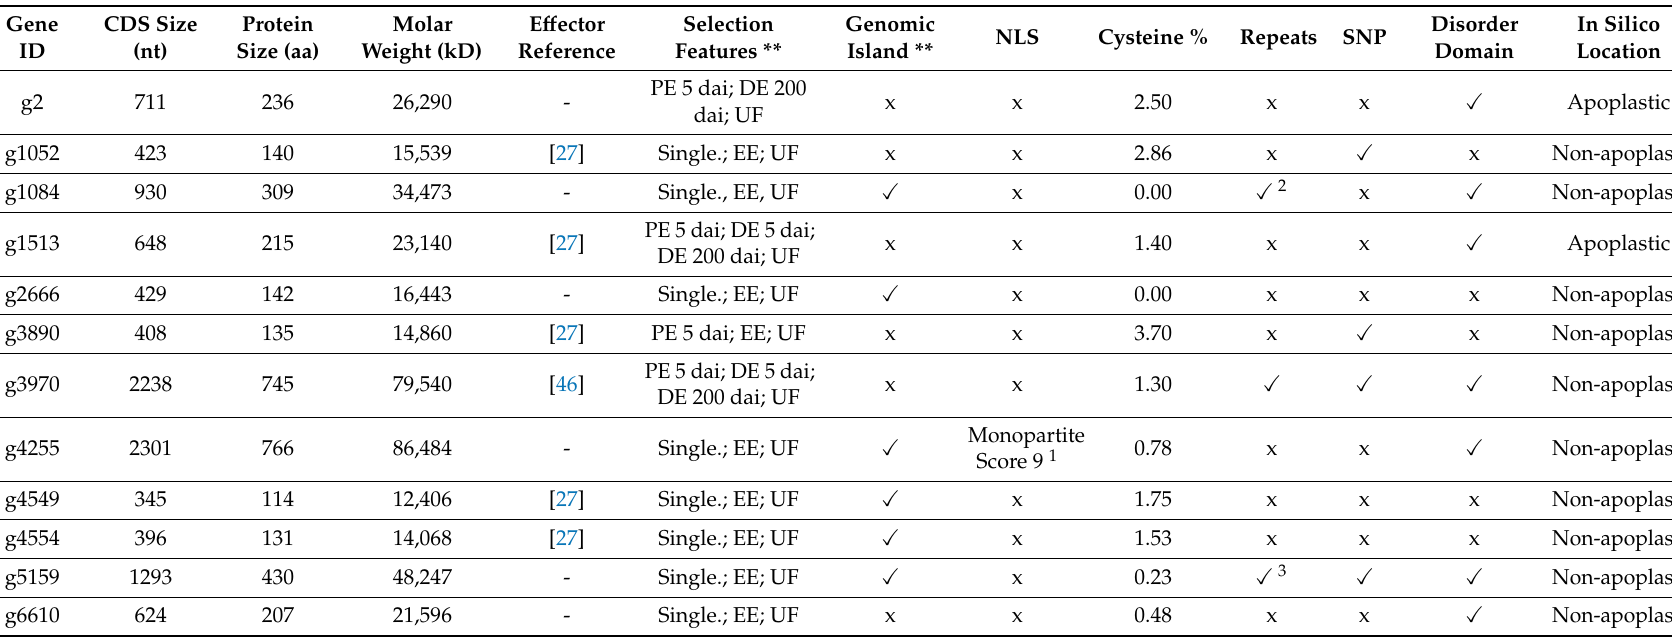
Table 1. Candidate e ff ector (CE) genes chosen based on their expression profile in two time points (see methods 2.3). Gene names in bold represent those CEs with no orthologs in other smut